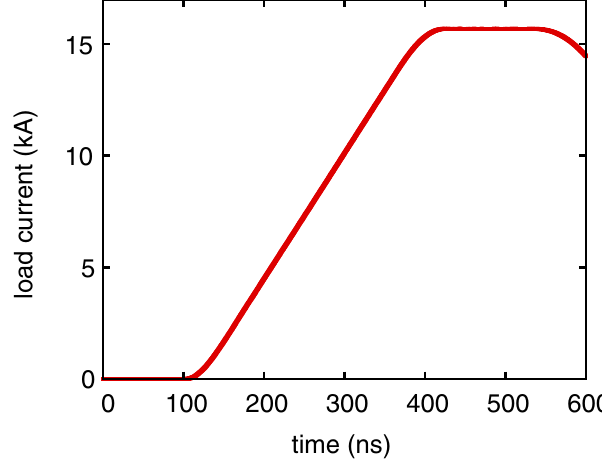
FIG. 9. Simulated load-current time history for a Neptune shot conducted with 600 Marx generators. The Marxes are triggered as required to achieve a 300-ns linear current ramp followed by a top that is flat to (cid:2) 0 . 5 % for 150 ns. The peak current is 15.7 MA.